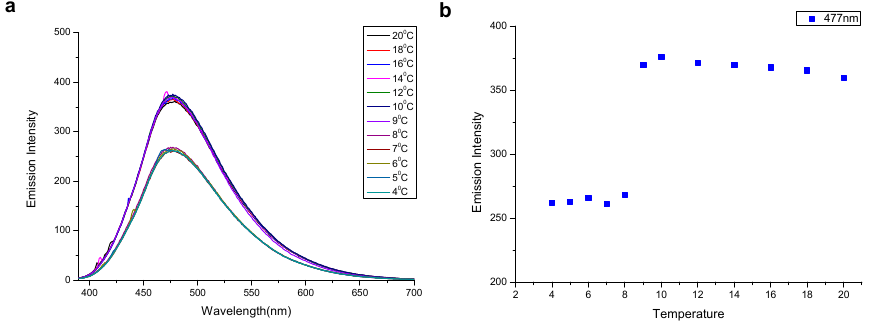
Figure 5. ( a ) Fluorescence emission spectra of PMEE-PDTriG at low temperatures, from 4 to 20 °C; ( b ) emission intensity at emission maxima, λ max versus temperature plot.